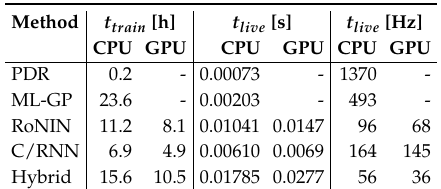
Table 3. Computational